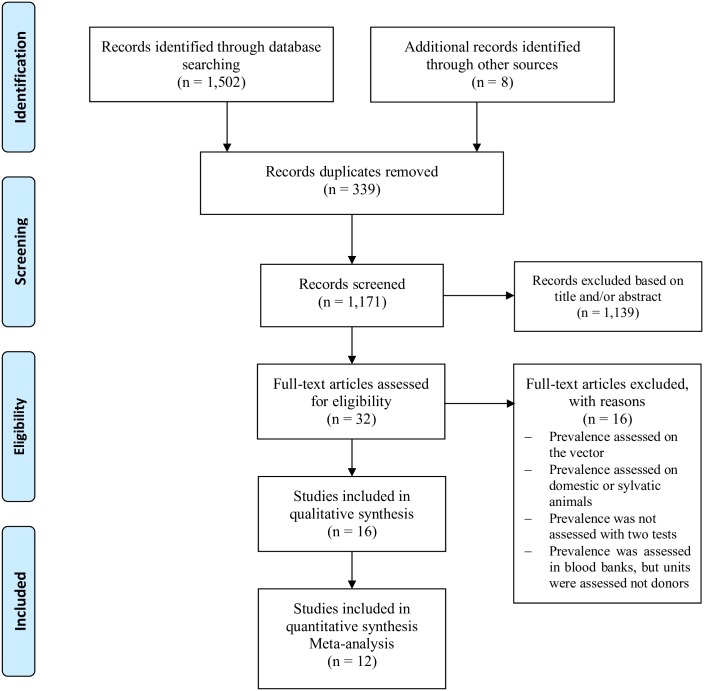
Flow diagram of the search and selection of studies on the prevalence of Chagas disease in Colombia from 2007 to November 2017.